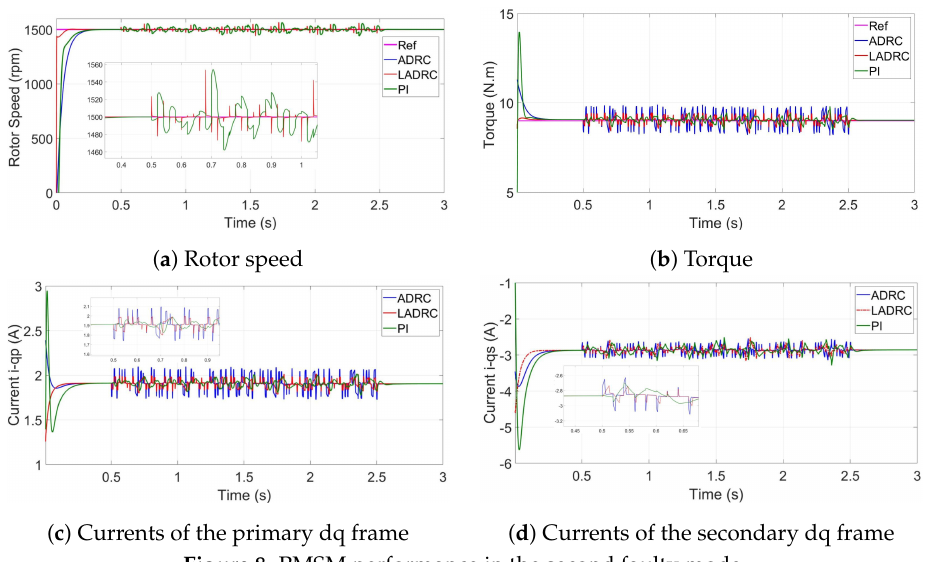
Figure 8. PMSM performance in the second faulty mode.